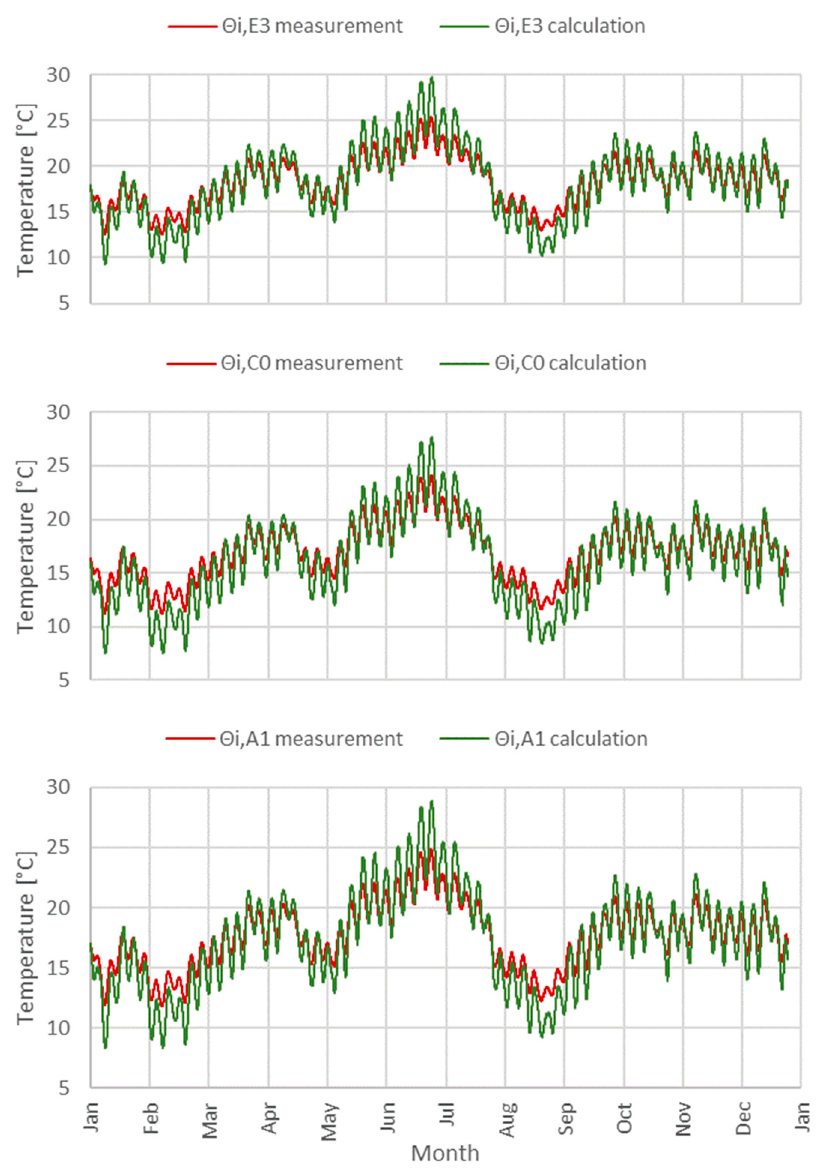
Figure 9. Selected curves of real and calculated indoor temperature in points E3, C0 and A1.